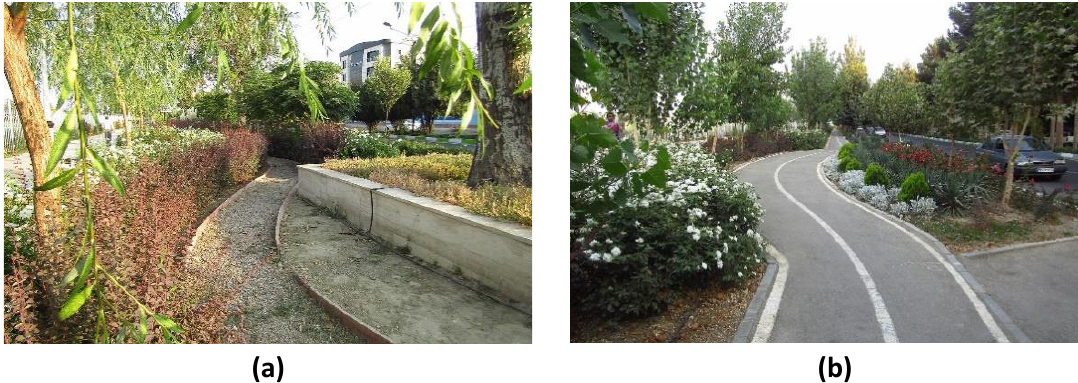
Fig. 6: (a) A creative low wide secondary path inside the middle green space; (b) Making the path more natural and attractive by curving the bicycle path